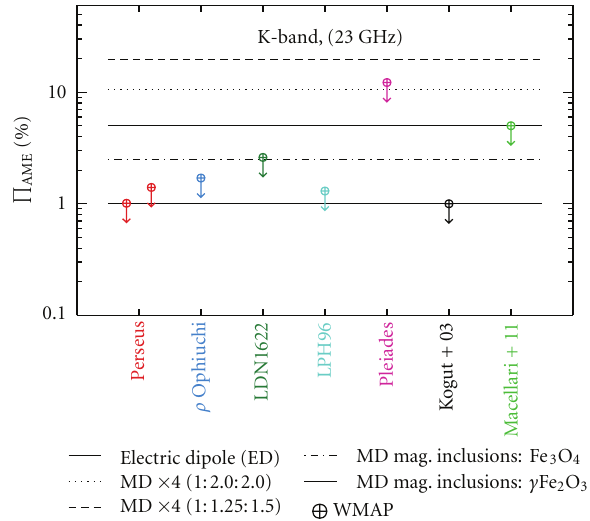
Figure 7: The same as Figure 6, but now for the Ka-band (31–